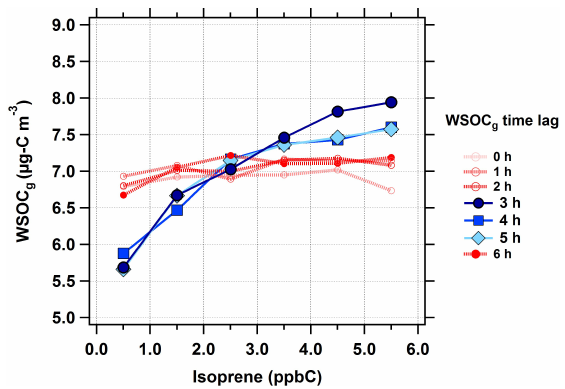
Figure 3. Median WSOC g concentrations as a function of isoprene concentrations (in ppbC or nmolCmol − 1 ) at different WSOC g time lags during the summer. The following isoprene concentrations bins were defined as follows: < 1ppbC, 1 to 2ppbC, 2 to 3ppbC, 3 to 4ppbC, 4 to 5ppbC, and > 5ppbC. Scatter and box plots showing individual data are presented in Fig.